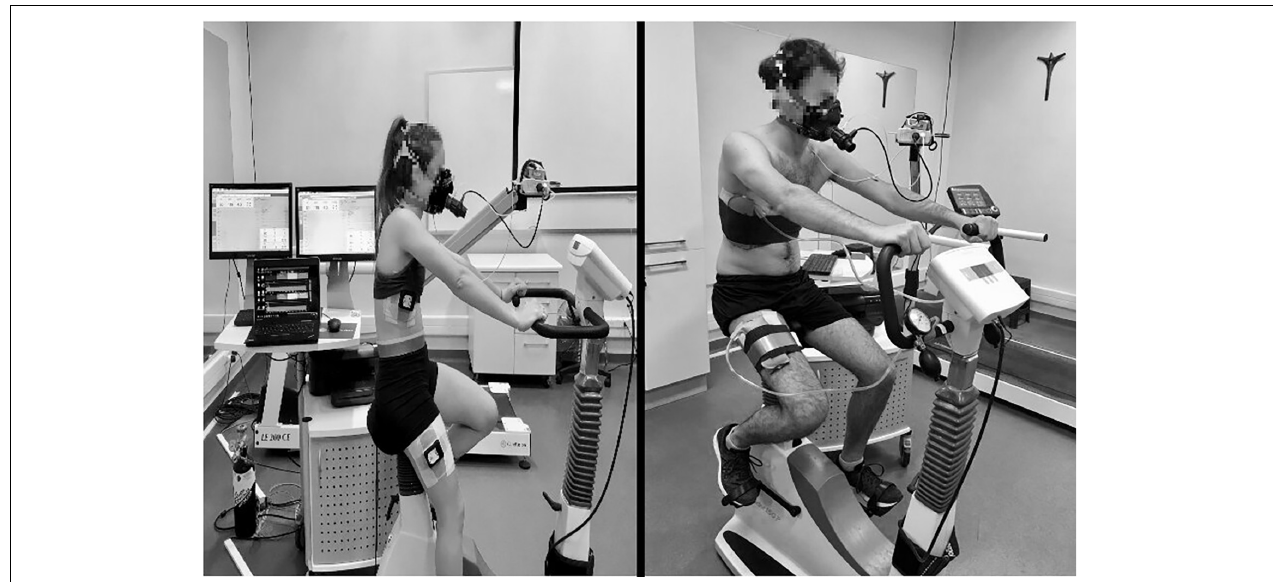
FIGURE 1 | The participant’s position on the cycle